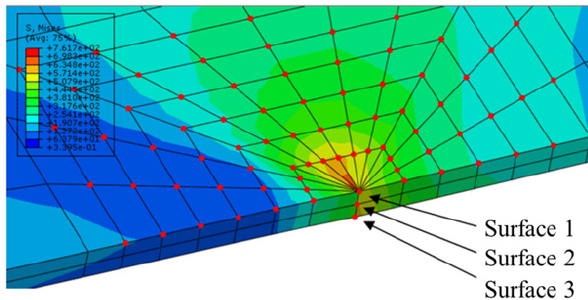
Figure 14: Node positions in seven contours chosen for the crack modeling. The number 1 is the surface where the stiffeners are bonded.